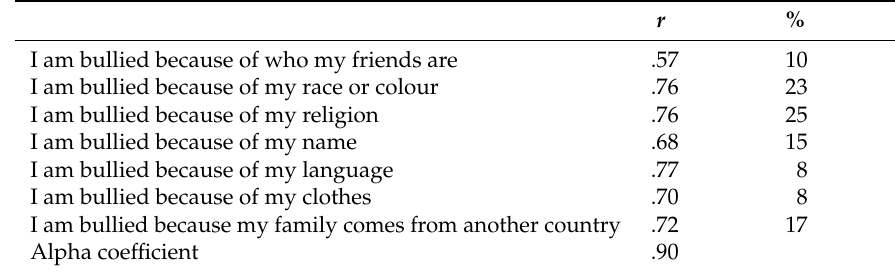
Table 1. Experience of Victimisation Index (EVI): Scale